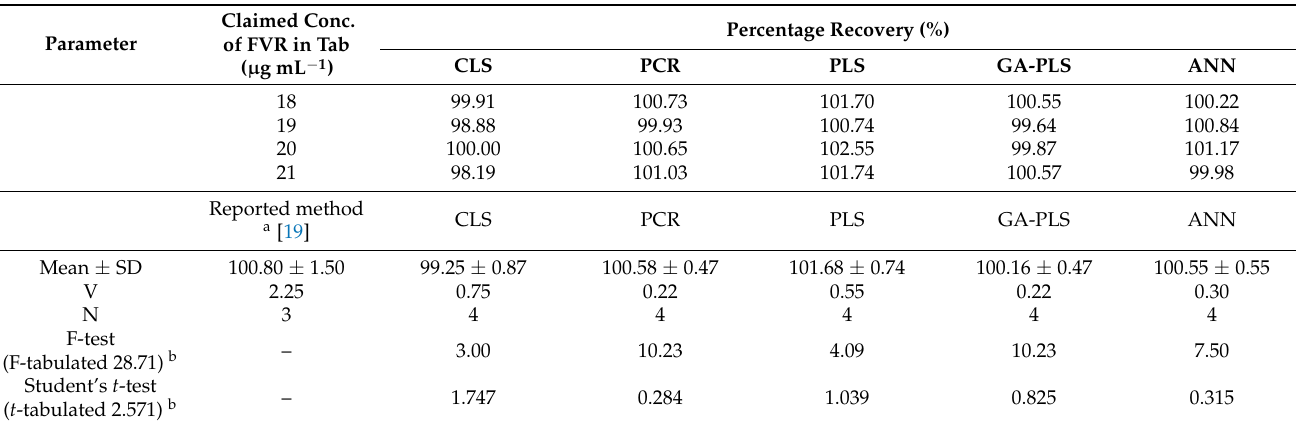
Table 3. The recovery results and statistical comparison between the results of FVR determination obtained by the proposed methods and the reported method [19] in the Avipiravir ®